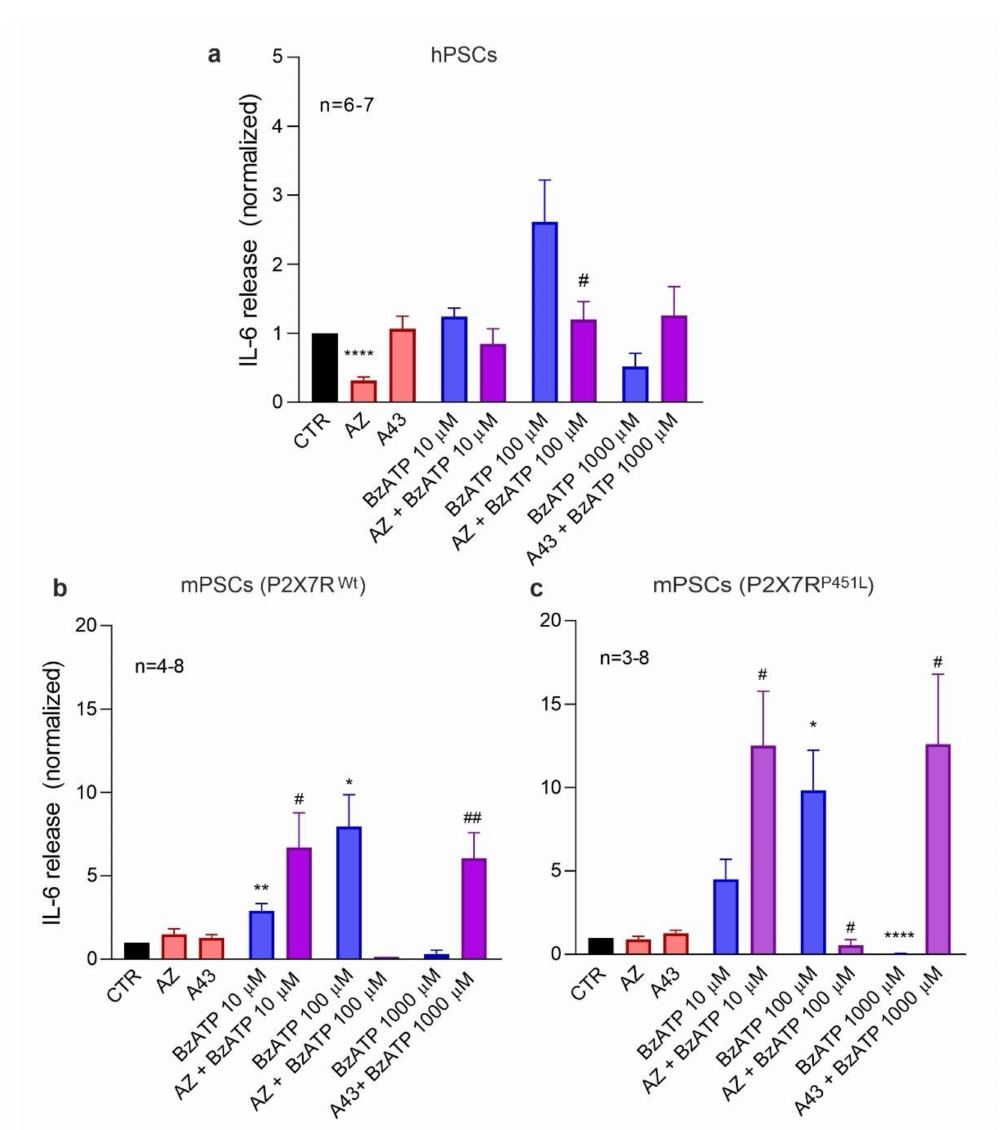
Figure 4. P2X7R -dependent IL-6 release. IL-6 release in ( a ) hPSCs and mPSCs from ( b ) P2X7R wt and ( c ) P2X7R P451L mice after treatment with different concentrations of the agonist BzATP (0, 10, 100, 1000 µ M) alone and in combination with 10 µ M inhibitor AZ10606120 (AZ) and A438079 (A43). Data were normalized to control values (CTR). One-sample t -test followed by Bonferroni correction was performed and significance compared to the control is indicated as follows * p < 0.05, ** p < 0.01, **** p < 0.0001.; comparisons between agonist and agonist + inhibitor have been evaluated with t -test and significance is indicated by # p < 0.05, ## p < 0.01. ( b ) n is reported in the graph except for AZ10606120 10 µ M + BzATP 100 µ M, where n = 2. For hPSCs BzATP 100 µ M, uncorrected p is 0.045; P2X7R wt BzATP 1000 µ M, uncorrected p is